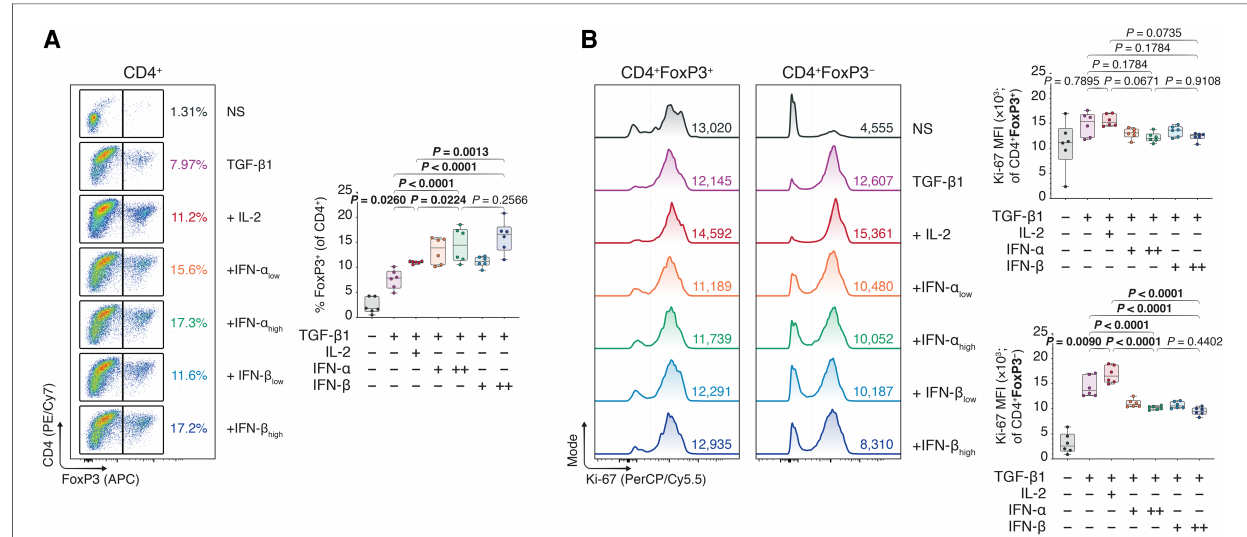
FIGURE 1 Type I interferons augment Foxp3 induction in naïve, conventional helper CD4 T cells. Murine CD4 + CD25 − T cells were magnetically isolated as per the manufacturer ’ s instructions and expanded for three days without stimulants (NS), or with anti-CD3 (1 μ g/ml), anti-CD28 (1 μ g/ml), and TGF- β 1 (10ng/ml; TGF- α α α β β β 1). In separate wells, IL-2 (20 ng/ml; +IL-2), IFN- α low (1,000 IU/ml; +IFN- low ), IFN- high (10,000 IU/ml; IFN- high ), IFN- low (1,000 IU/ml; +IFN- low ), or IFN- β β 1 condition ( n =3 technical replicates/condition; 2 experiments). ( A ) Flow cytometric analysis and box β high (10,000 IU/ml; IFN- high ) were added to the TGF- plots of FoxP3 + T regs among CD4 + T cells. ( B ) Flow cytometric analysis and box plots of Ki-67 mean fl uorescence intensities (MFIs) among CD4 + FoxP3 + T regs and CD4 + FoxP3 − non-T regs . Data represent boxplots with median, interquartile range, minimum, maximum, and all individual data points of the denoted experimental groups. P values were calculated with one-way analyses of variance followed by Holm- Š ídák multiple comparison tests were performed. IFN- α , interferon alpha; IFN- β , interferon beta; IL-2, interleukin 2; MFI, mean fl uorescence intensity; NS, non-stimulated; TGF- β 1, transforming growth factor beta